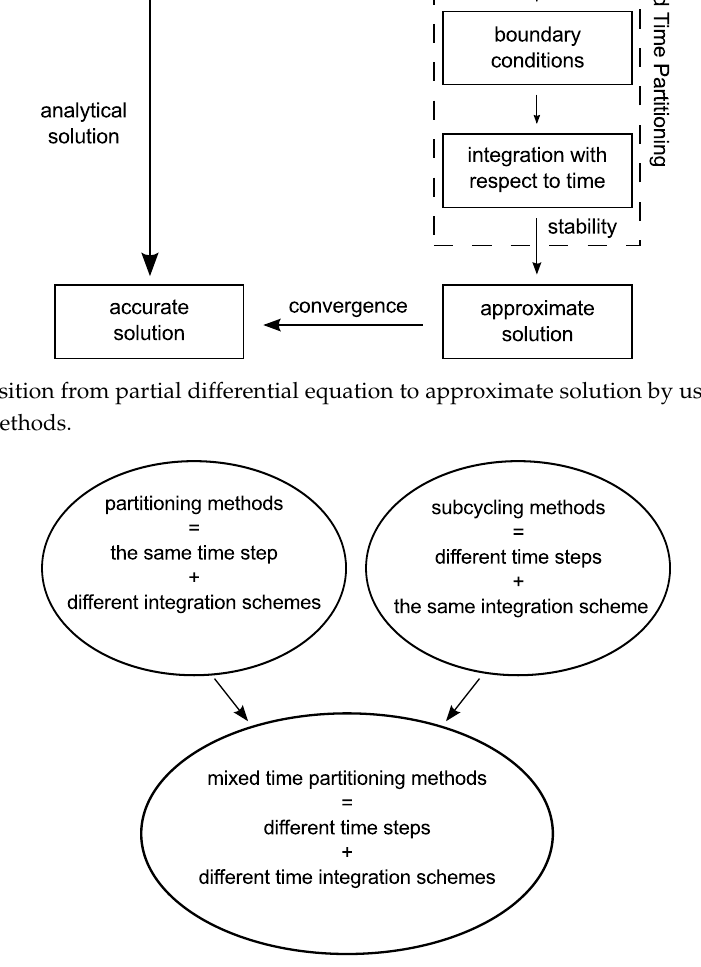
Figure 2. Origin of mixed time partitionig